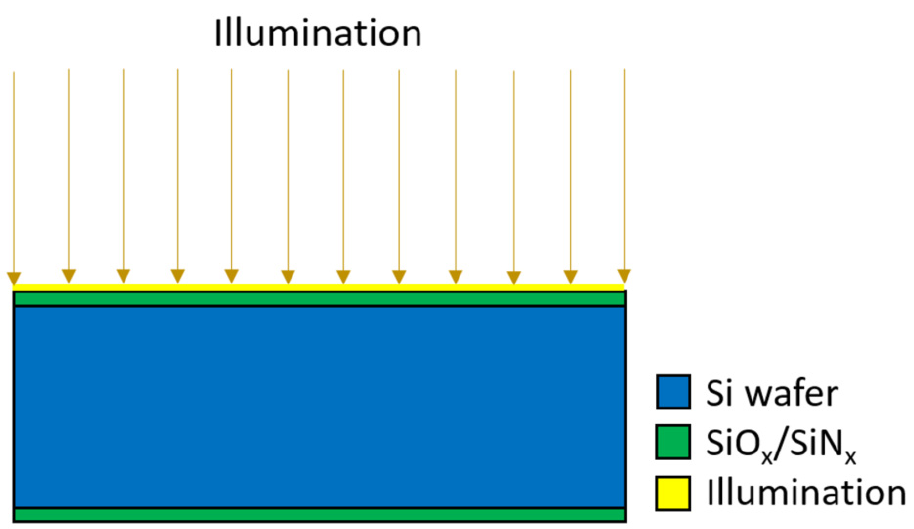
Figure 3. 2D lifetime simulation structure.